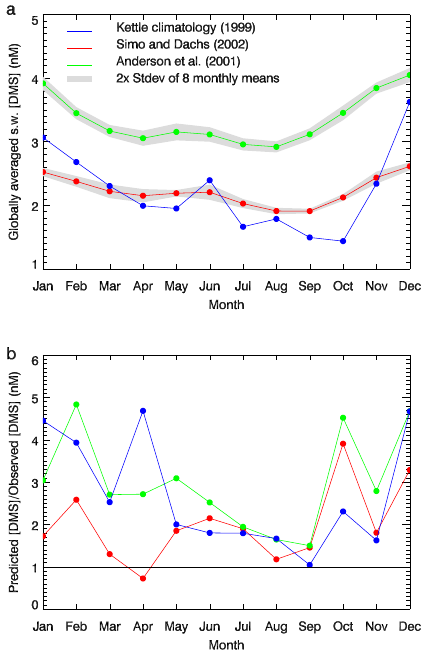
Fig. 1. (a) Monthly global mean surface ocean [DMS] from the Kettle climatology (blue curve), mean of monthly global means from eight years of model data using the Anderson (2001) scheme (green curve), and eight years of model output using the modified Simo (2002) scheme (red curve), with two standard deviations of the model data illustrated by the grey bands. (b) Model and clima- tology predicted surface ocean [DMS] divided by observed [DMS] (averaged within 1 × 1 degree latitude-longitude grids), at locations where observations have been made between 2000 and 2009 (i.e. us- ing data independent from that used to create the climatology and parameterisations, and averaged into 1 × 1 degree